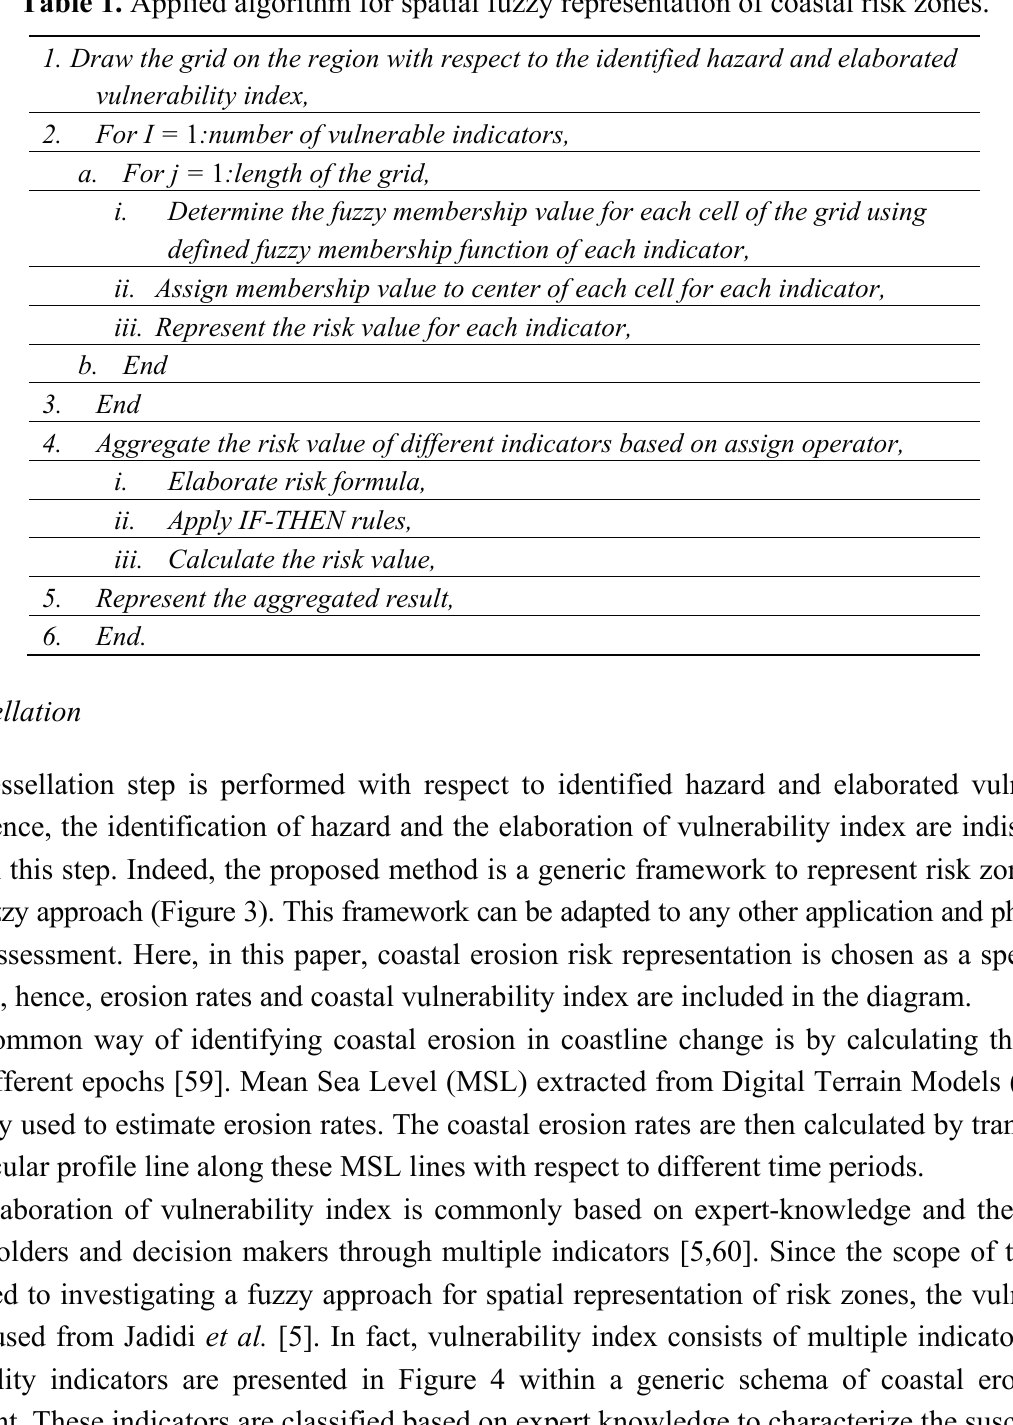
Table 1. Applied algorithm for spatial fuzzy representation of coastal risk